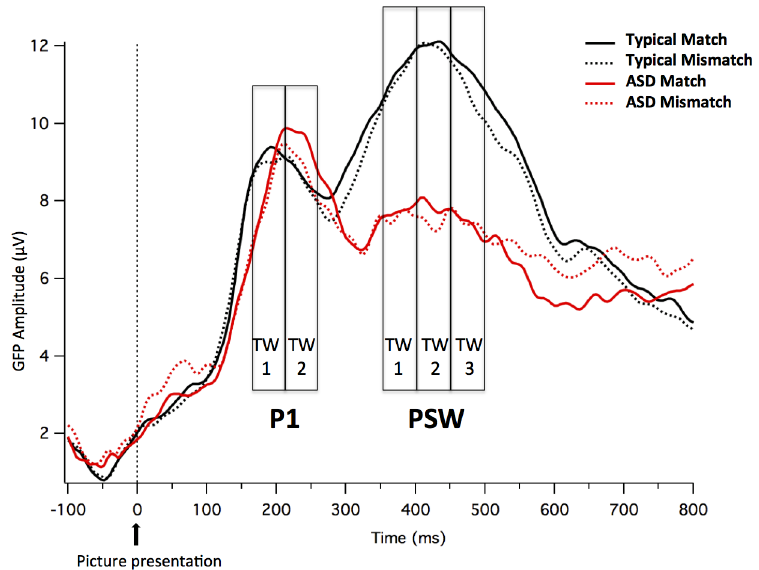
Fig 2. GFP of visual evoked potentials. GFP measures time-locked to the picture for the two groups (Neurotypical and ASD children) and the two conditions (Match and